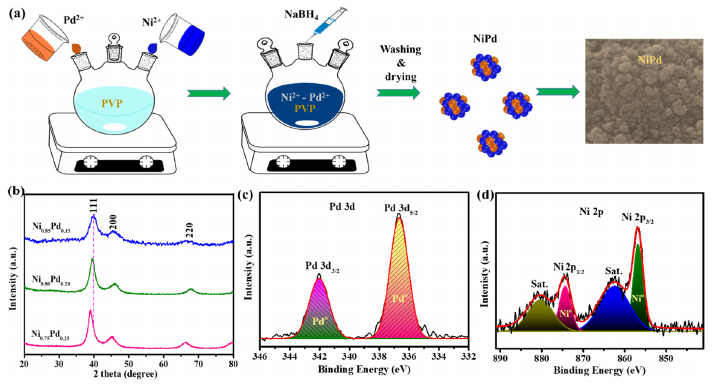
Figure 1. ( a ) Schematic illustration of the formation of Ni (1 − x) Pd x alloys, ( b ) XRD pattern for the three Ni (1 − x) Pd x alloys, ( c ) XPS high-resolution deconvoluted spectrum of Pd 3d, and ( d ) XPS high-resolution deconvoluted spectrum of Ni 2p.